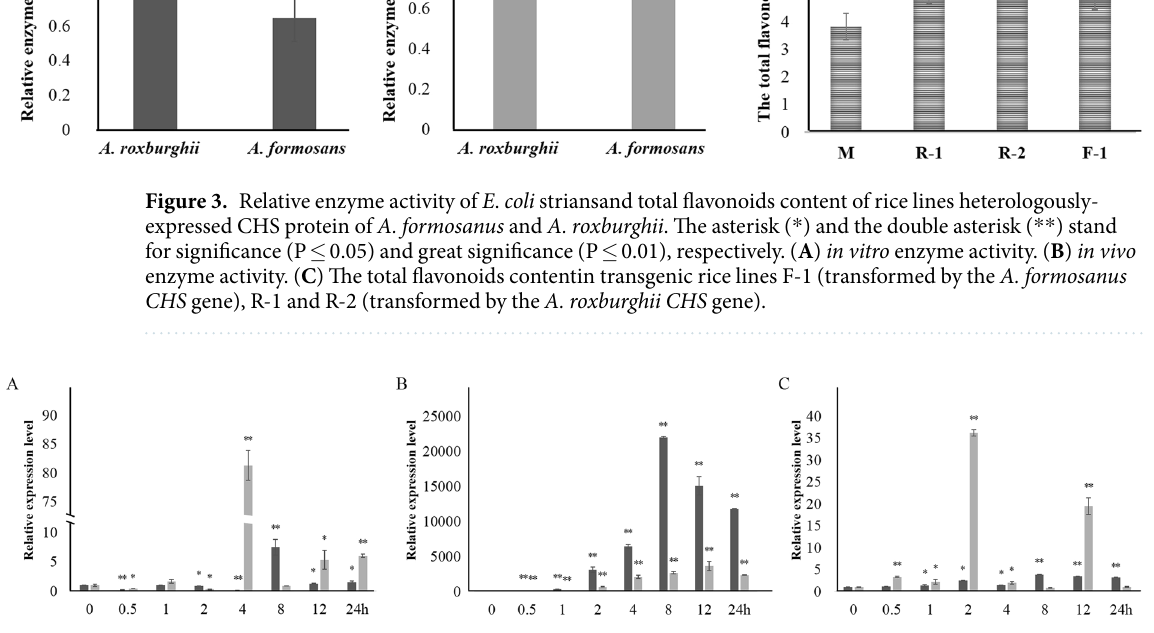
Figure 4. Relative expression levels of gene CHS of A. roxburghii and A. formasanus under Phe, UV and NaCl induction. The lighter and the darker columns represent A . roxburghi and A . formosanus , respectively. The asterisk ( * ) and the double asterisk ( ** ) stand for significance (P ≤ 0.05) and great significance (P ≤ 0.01), respectively. ( A ) Phe induction. ( B ) UV induction. ( C ) NaCl induction.